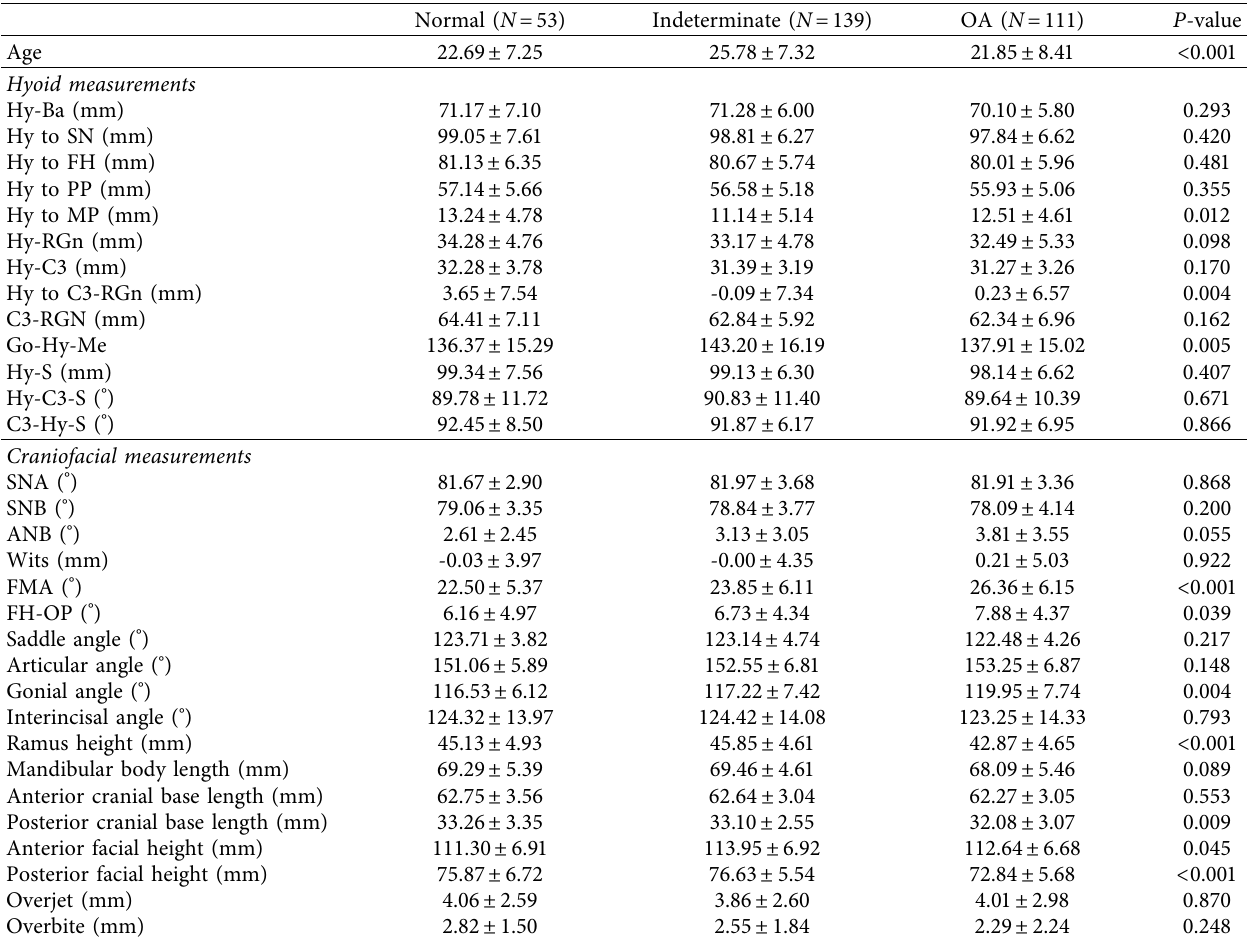
Table 5: Differences in hyoid and craniofacial measurements among the three groups in female